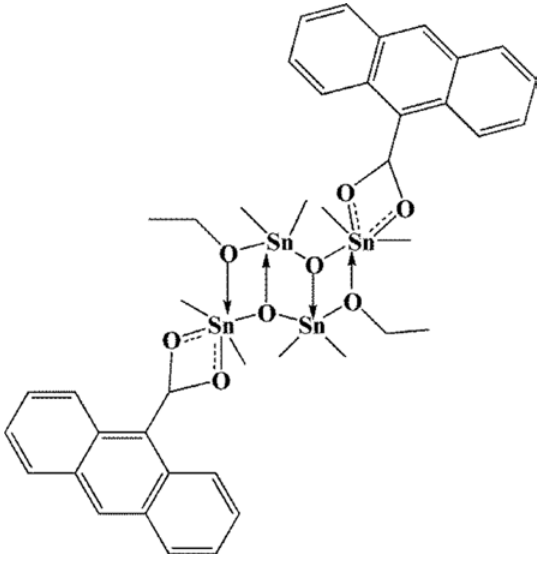
Scheme 1: Line drawing structure of the prepared tin(IV) compound.